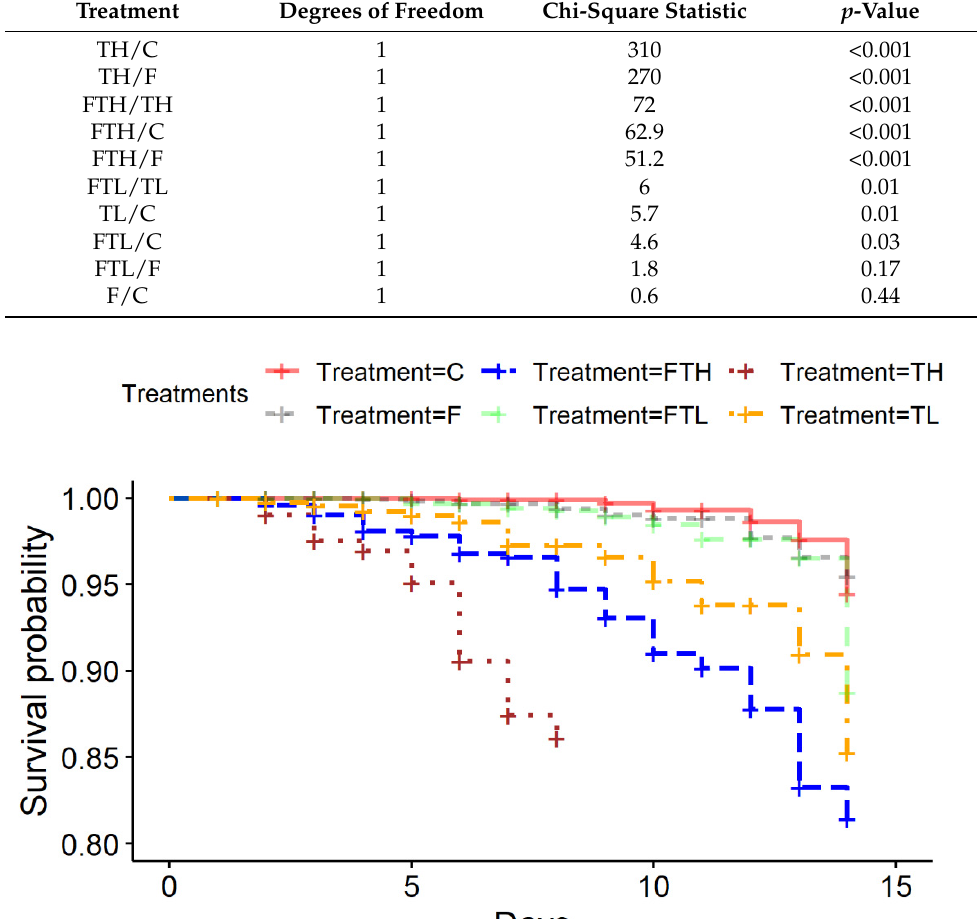
Table 3. The results of the log-rank test, which was used to compare different treatment groups of bees treated using various chemical substances.